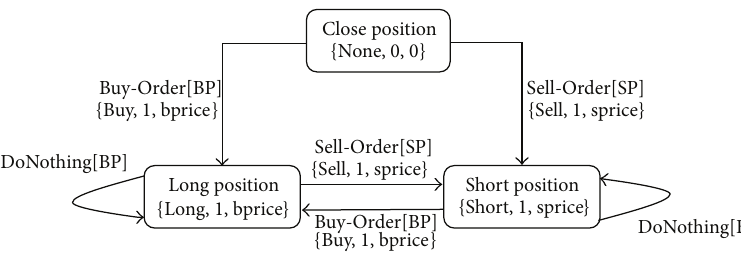
Figure 1: The state machine of an interday trading model.